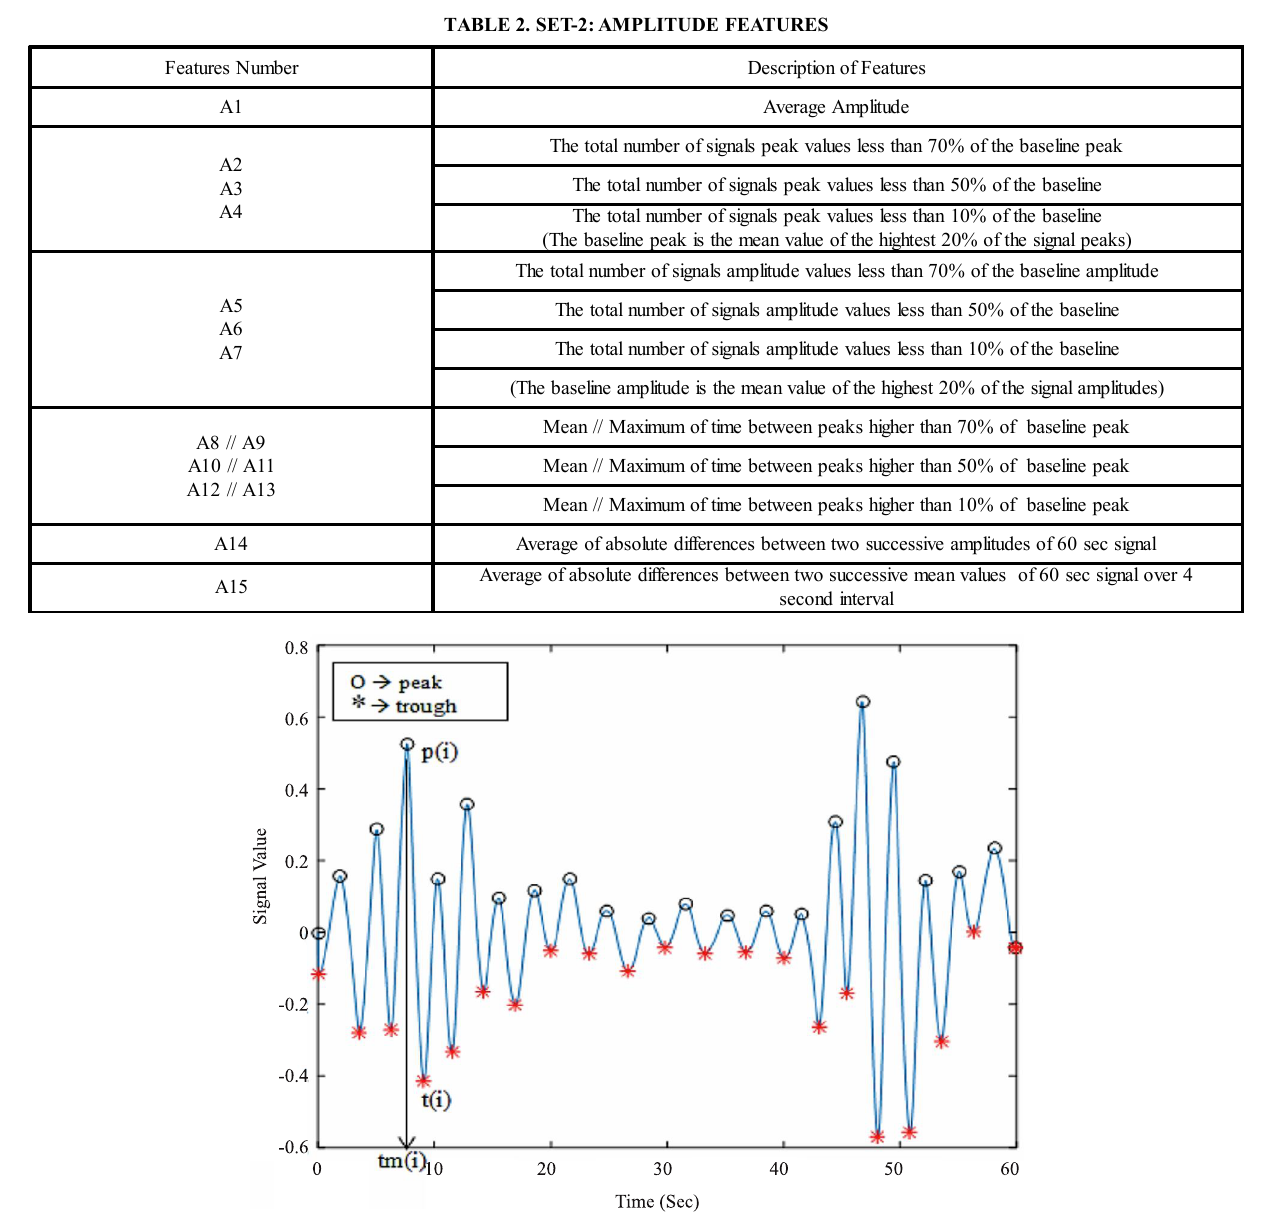
FIG. 3. PEAK, TROUGH POINTS AND TIME OF